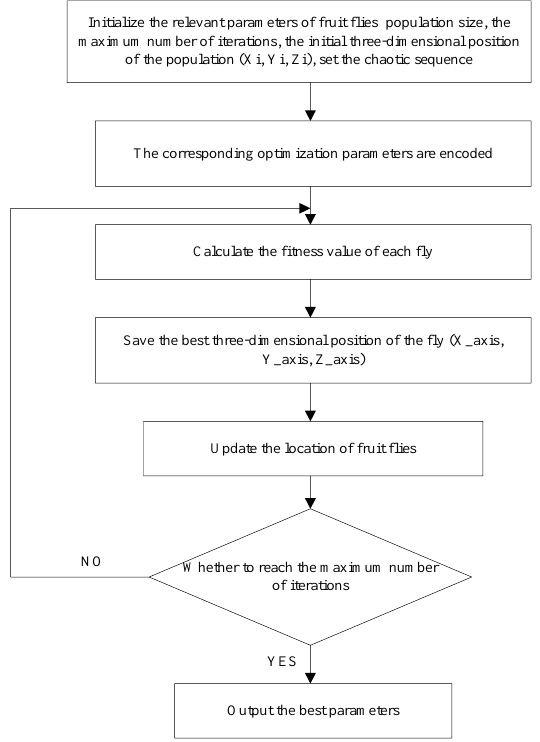
Figure 1: Three dimensional chaotic fruit fly flow